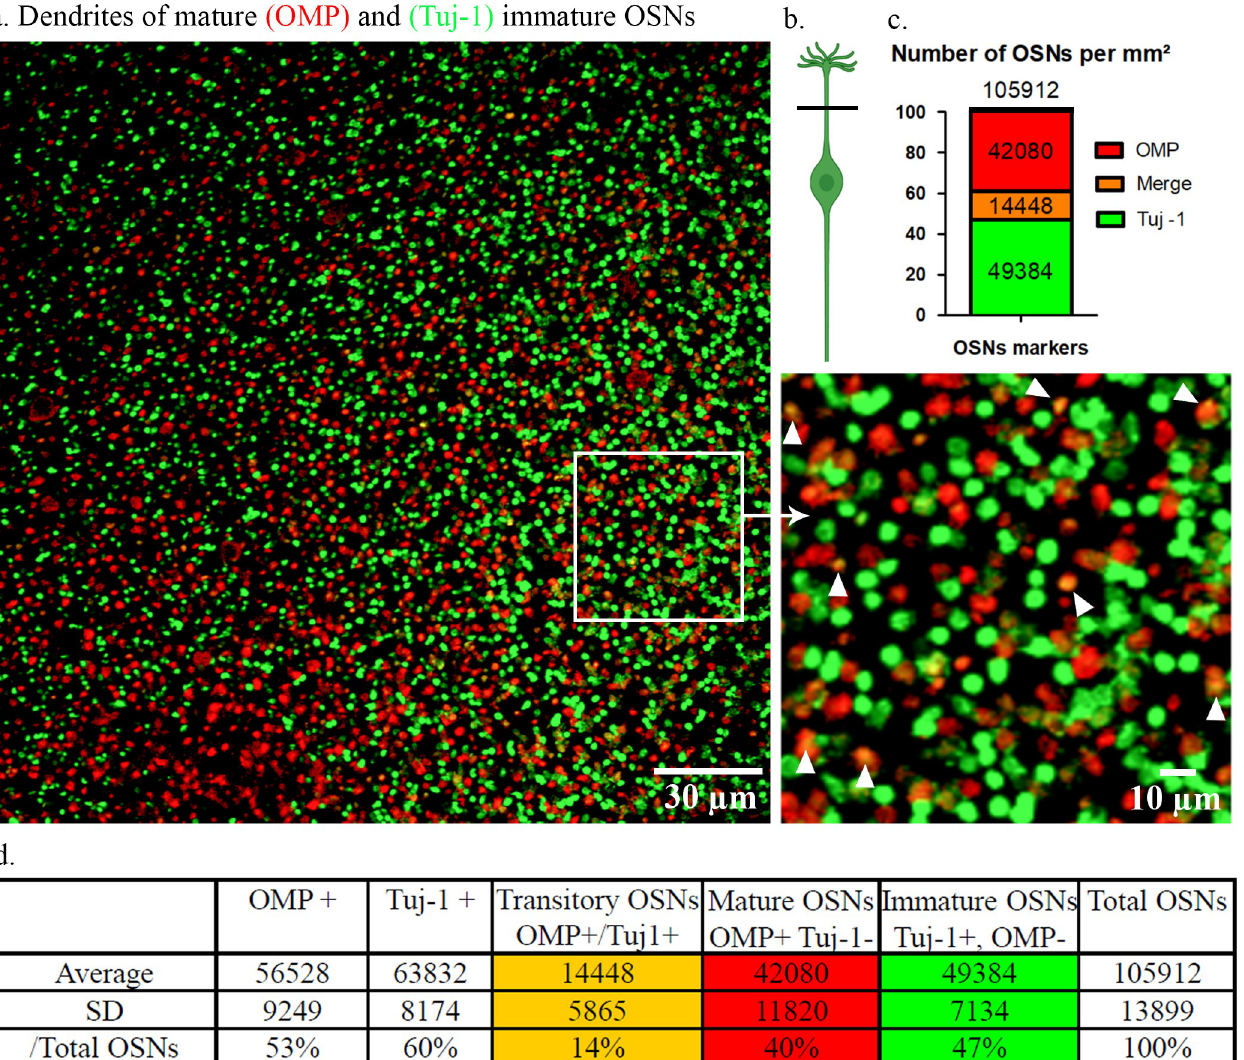
Fig 6. OSN density evaluation using immunostaining of dendrites on flat-mounted septal OE. a) Double immunostaining was done on the separated septum mucosa. The mature OSNs were stained in red using OMP and the immature OSNs were stained in green using Tuj-1. The co-stained OSN dendrites (Tuj-1+, OMP+) which appear in yellow/orange, were indicated by arrow heads. Images were acquired using a confocal microscope with a 60X objective. b) The horizontal black line illustrates the Z level of OSN where the image was acquired. c) and d) In total, 105912 ± 13899 OSN/mm 2 were detected by this method: 49384 ± 7134/mm 2 were immature OSNs (Tuj-1+, OMP-), 42080 ± 11820/mm 2 were mature OSNs (Tuj-1-, OMP+), and 14448 ± 5865/mm 2 were transitory OSNs (Tuj-1+, OMP+). The percentage in the table corresponds to the cell number ratio compared to the total number of OSNs (105912). n = 15 (3 animals and 5 different fields per